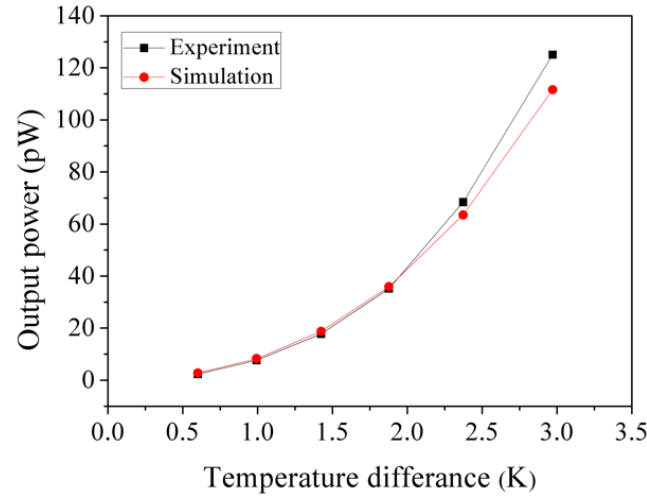
Figure 15. Measured OP of the microgenerator. Table 1. Voltage factor and power factor for TMG.